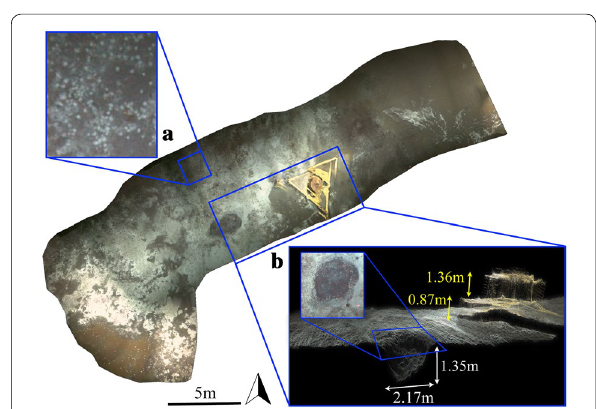
Fig. 5 3D reconstruction of the area around the C0014G artificial hydrothermal vent mapped in a single swath. Detail view A shows a colony of S. crosnieri . Detail view B shows the open drill hole C0014D/E, which is also populated by a large number of S.